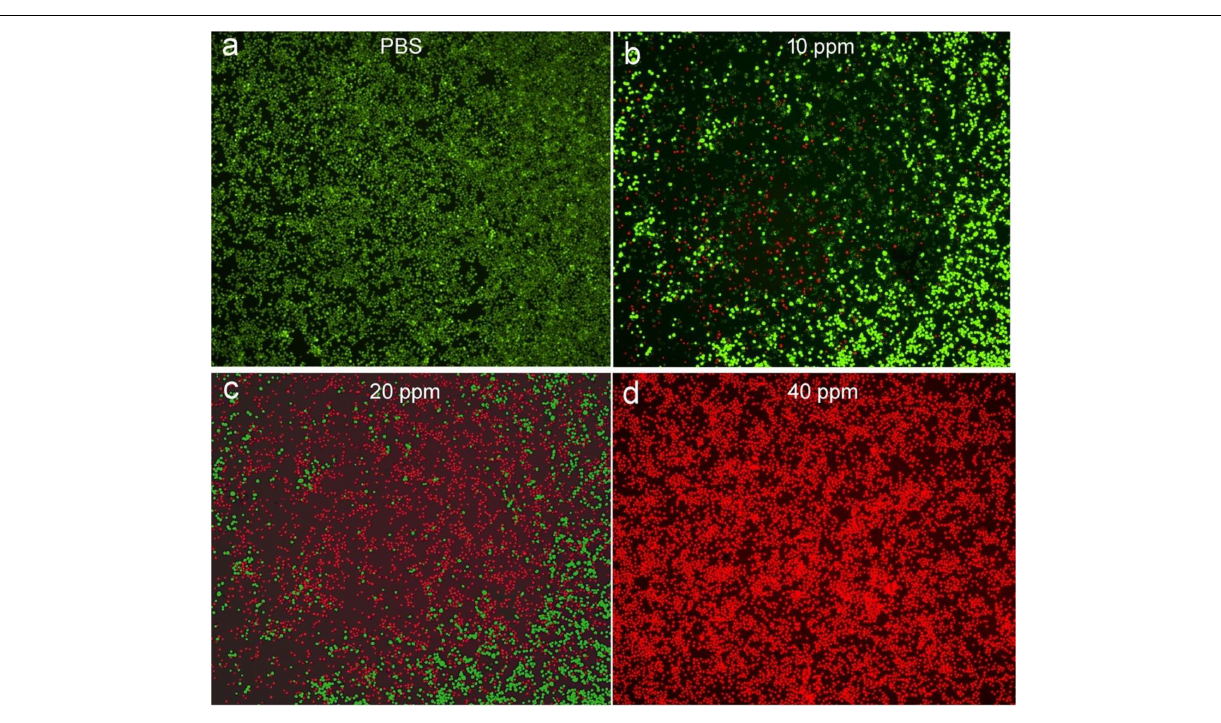
FIGURE 5 | Fluorescence images of Calcein AM/Propidium iodine-stained K7M2 cells after incubation with (a) PBS solution and (b–d) the CuFeS 2 nanoassemblies at different concentrations (10, 20, and 40 ppm) followed by laser irradiation at 808